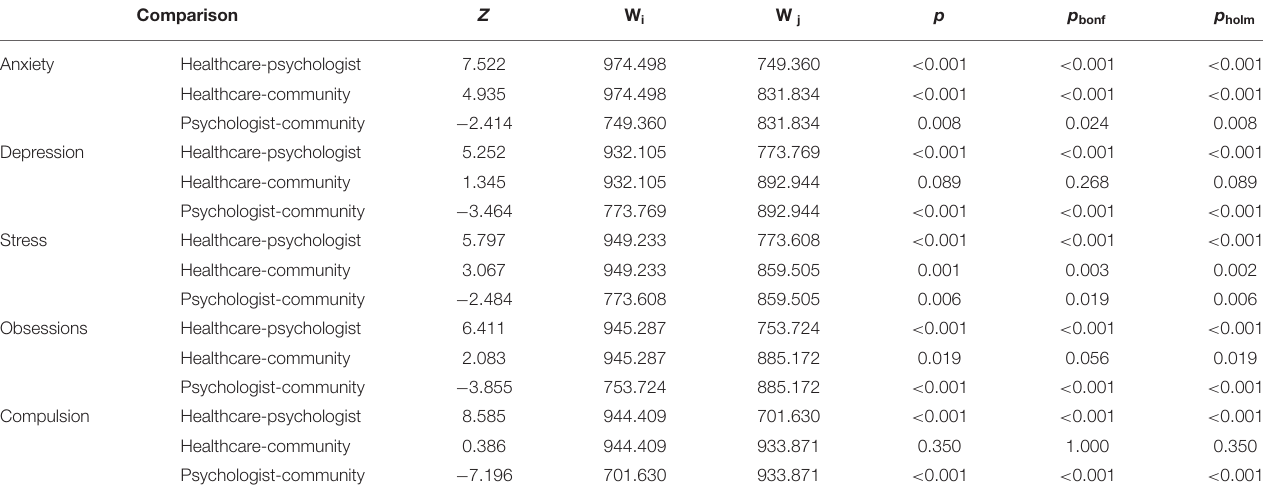
TABLE A1 | Dunn’s post-hoc comparisons across groups.